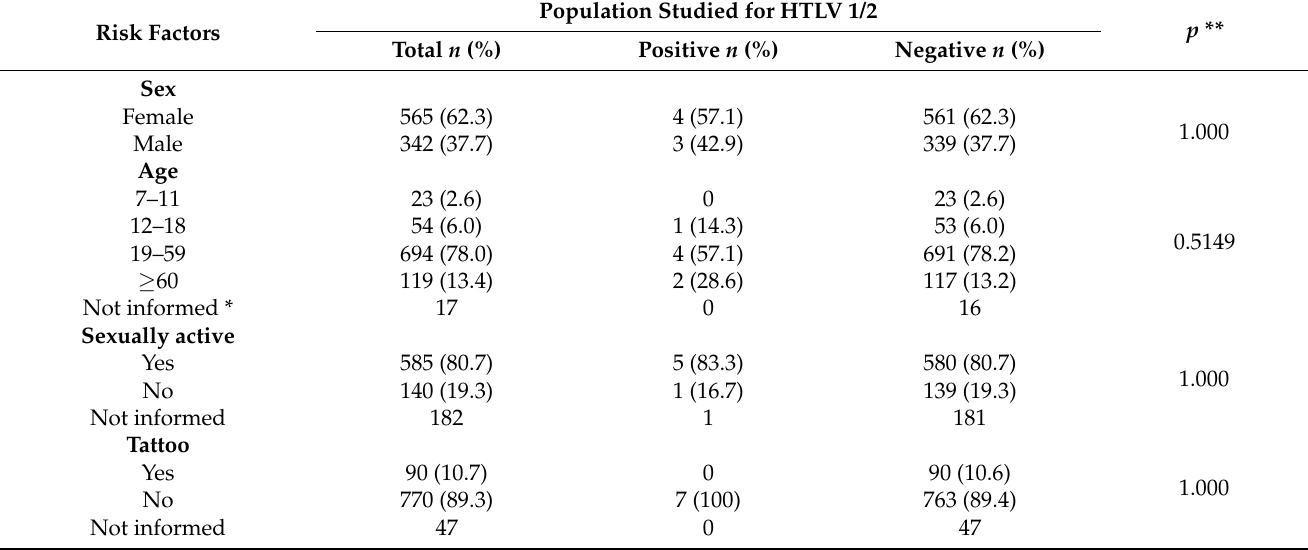
Table 2. Risk characteristics for contracting HTLV 1/2 infection in rural and riverine populations of the state of Par á